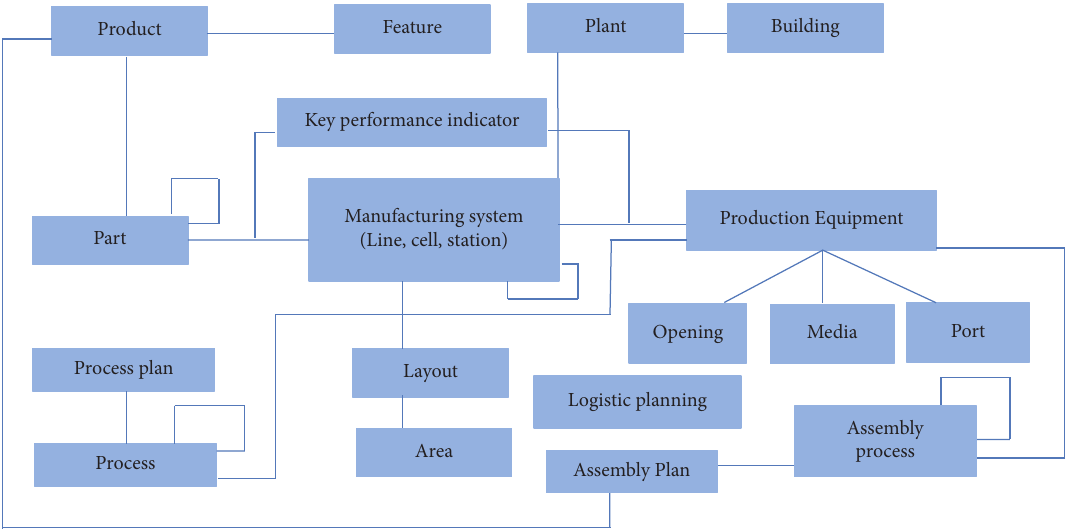
Figure 10: Data model in Innovator (The PLM IT system, simplified version).